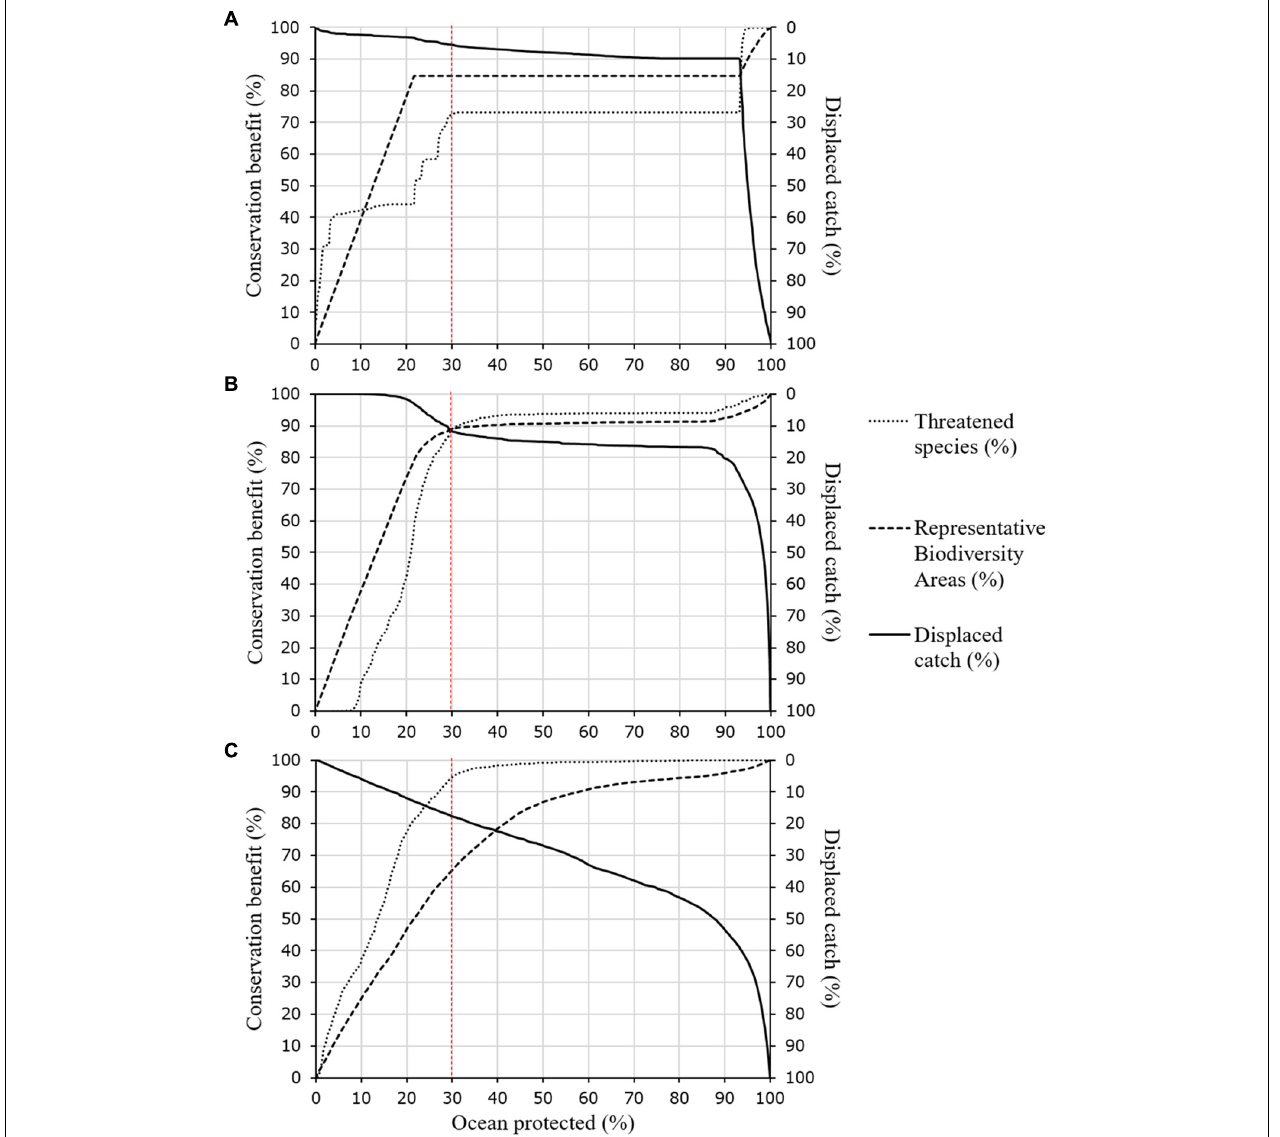
FIGURE 4 | Each Zonation scenario resulted in trade-offs between objectives as ocean protection increased. Dashed red line shows 30% ocean protection. Panel (A–C) denotes Zonation scenario (A) Scenario 1, prioritising food security above conservation, (B) Scenario 2, protecting food security, biodiversity and threatened species, (C) Scenario 3, balancing objectives while addressing spatial bias using administrative